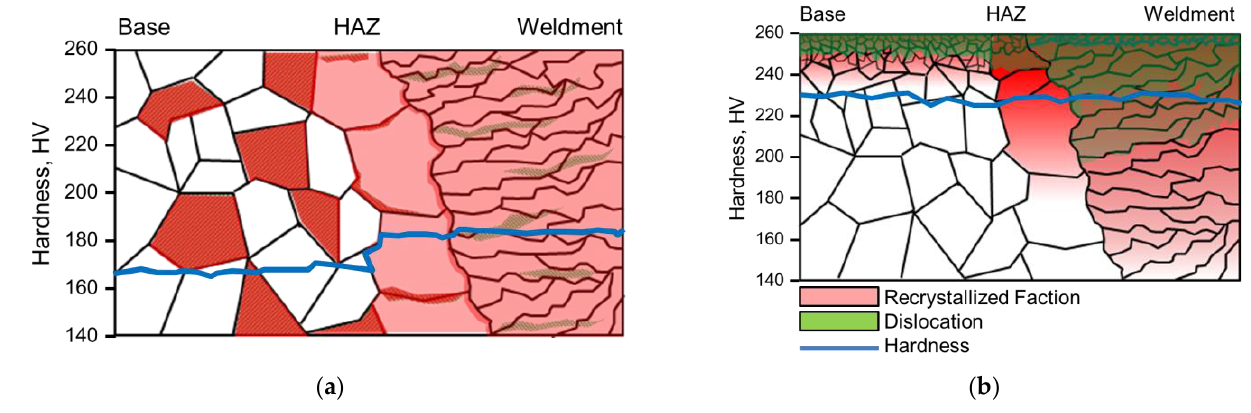
Figure 14. Proposed model of the microstructural variation in 304L stainless steel by ( a ) welding and ( b ) laser peening.